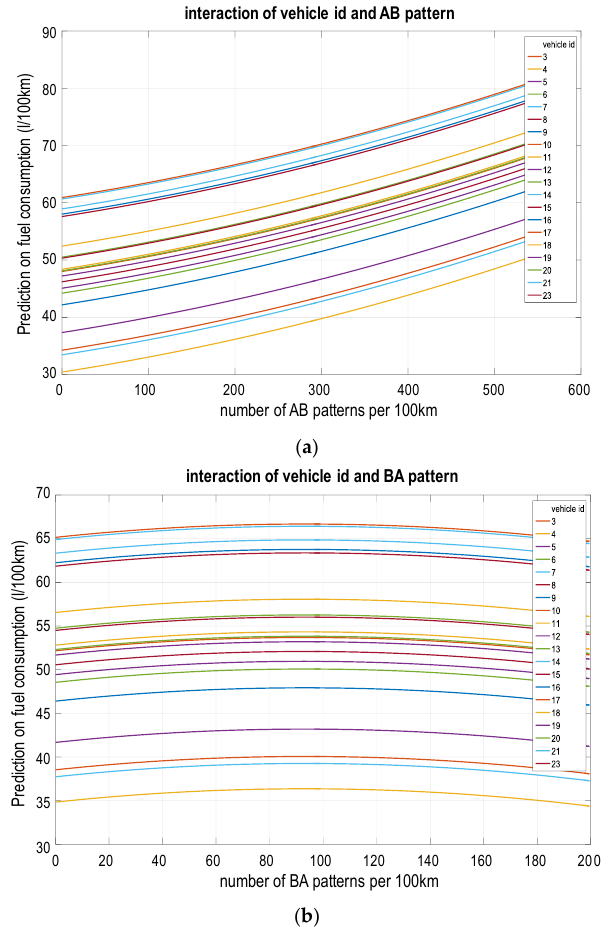
Figure 11. Effect on changing AB and BA patterns for the evaluated buses. ( a ) Effect on changing AB pattern; ( b ) Effect on changing BA